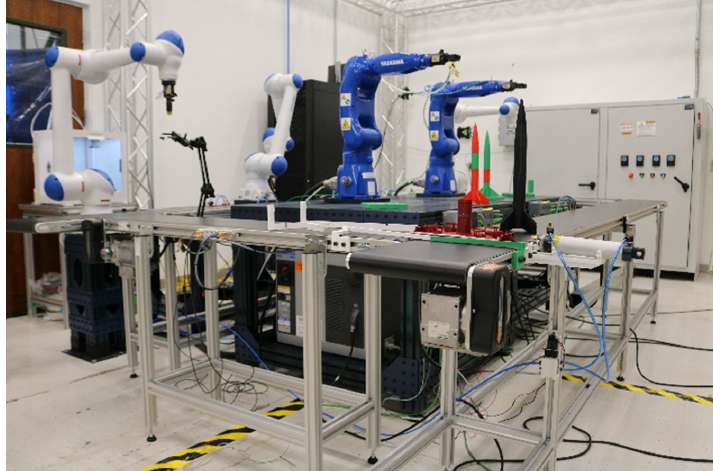
Figure 22. The neXt Future Factory Test Bed at University of South